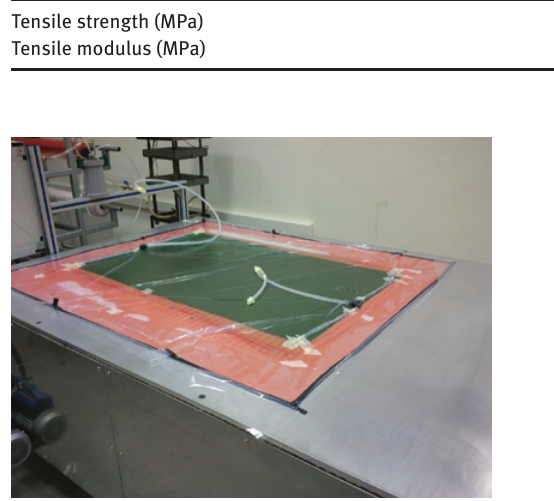
Figure 1: The fabrication of glass fibre-reinforced epoxy composite plate.